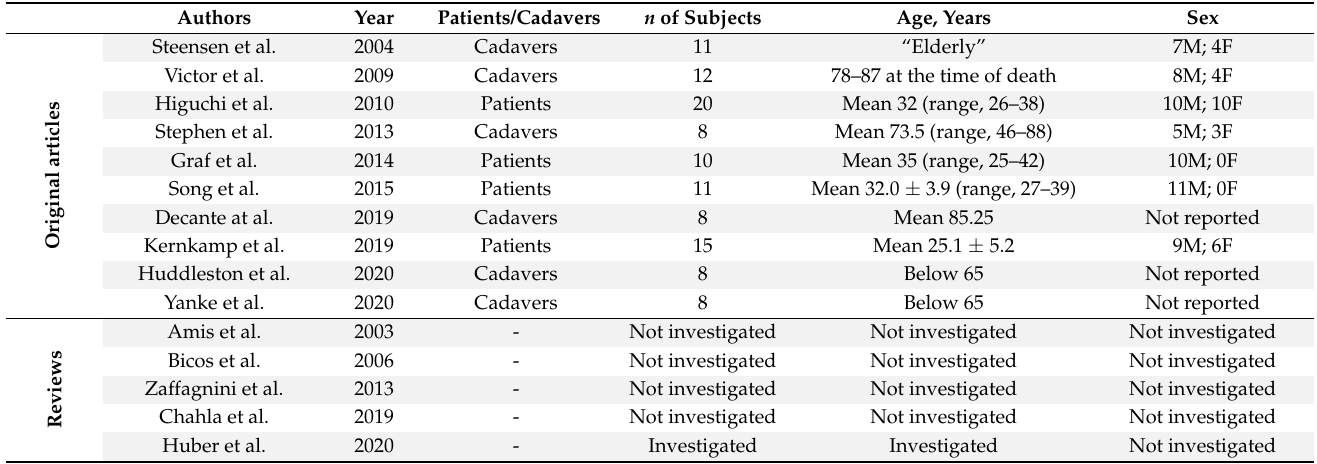
Table 1. Demographics within included